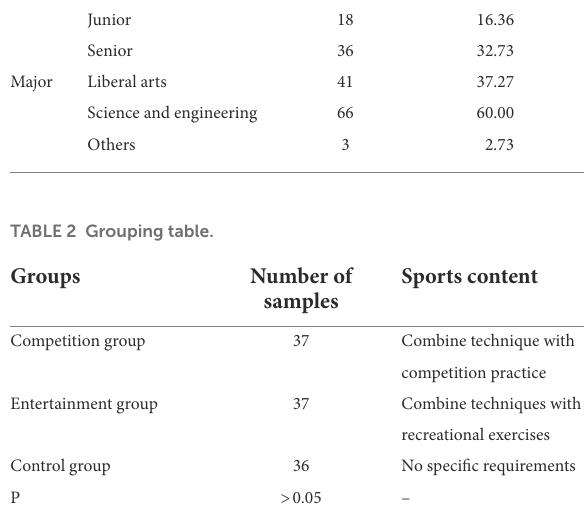
FIGURE 1 The framework model.